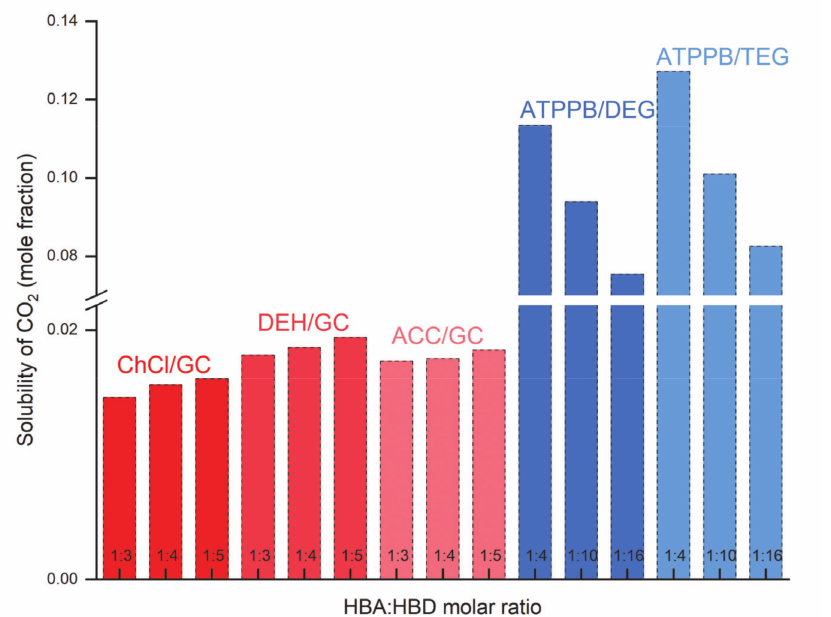
Figure 6. Effect of the molar ratio of DESs on the solubility of CO 2 at 303.15 K and under 0.5 MPa. Data are extracted from